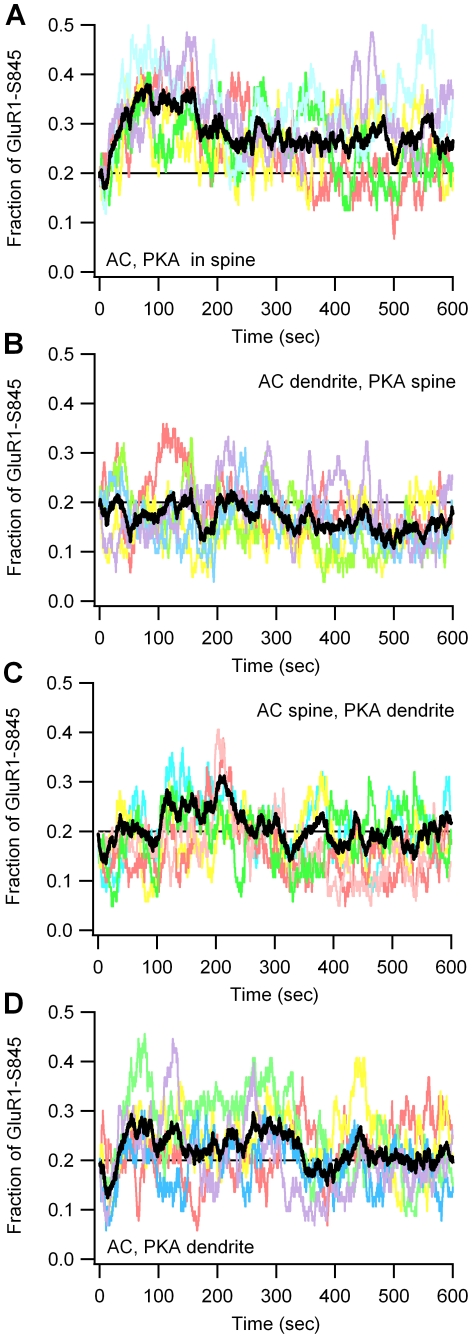
Fraction of GluR1 phosphorylated on Ser845 for 5 individual trials (shown in different colors) fluctuates due to stochastic nature of simulations.Black traces shows the average of 5 trials which differ only in the random seed used to start the simulations. (A) When PKA and adenylyl cyclase are colocalized in the spine, GluR1 phosphorylation increases for each trial. (B,C) When PKA is separated from adenylyl cyclase, most trials show a decrease in GluR1 phosphorylation; but some trials show an increase. (D) When PKA is colocalized with adenylyl cyclase in the dendrite, most trials show an increase in GluR1 phosphorylation; but some trials show a decrease.